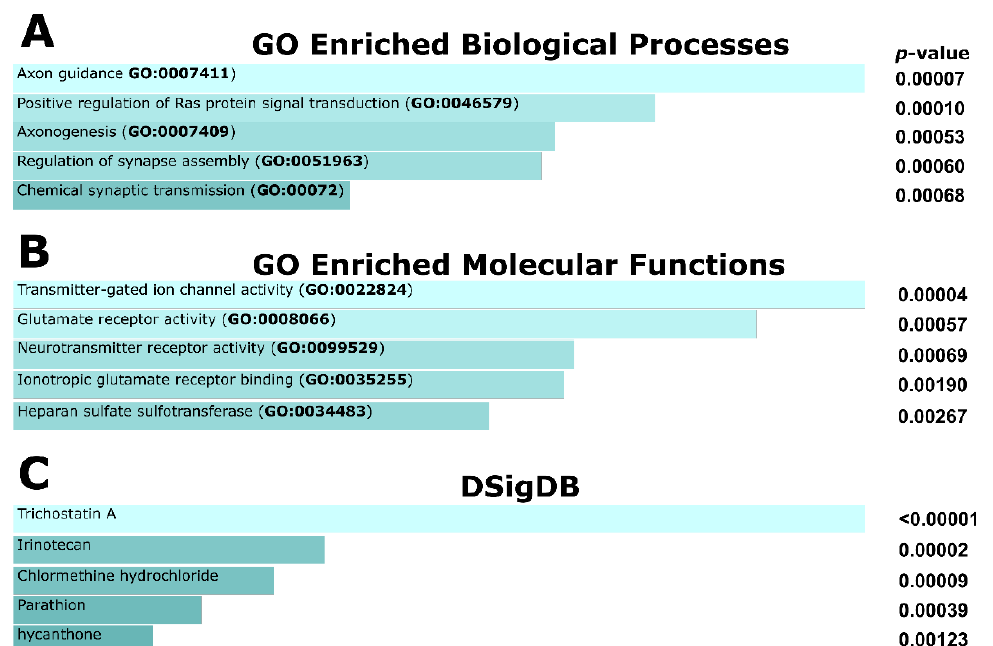
Figure 1. The top five significantly enriched gene ontology terms associated with RTGs as determined by the EnrichR software. ( A ) Biological processes, ( B ) molecular functions, and ( C ) Drug Signatures Database (DSigDB). Pathways are presented based on the combined EnrichR score. DSigDB relates drugs/compounds to their target genes.